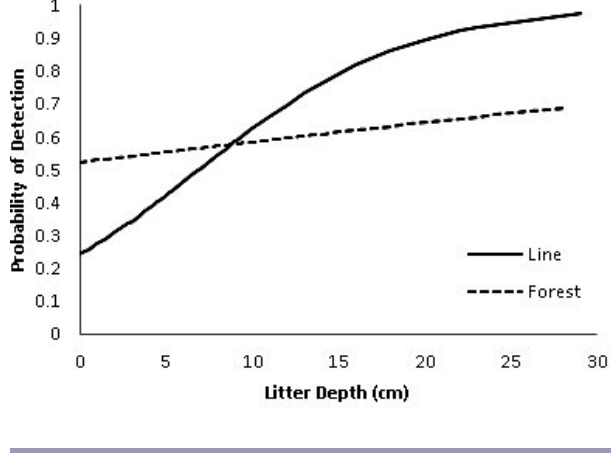
Fig. 3 . Probability of detecting arthropods in a 15-cm diameter litter core as a function of litter depth on seismic lines and in the forest.